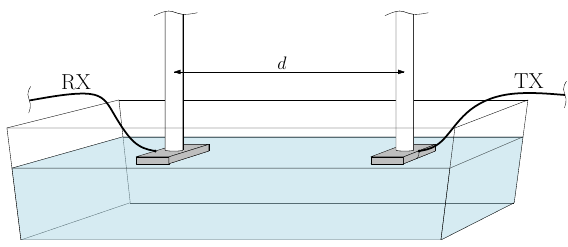
Figure 1: Experiment setup showing electrode placement and fluid. d denotes the distance between the centre of the